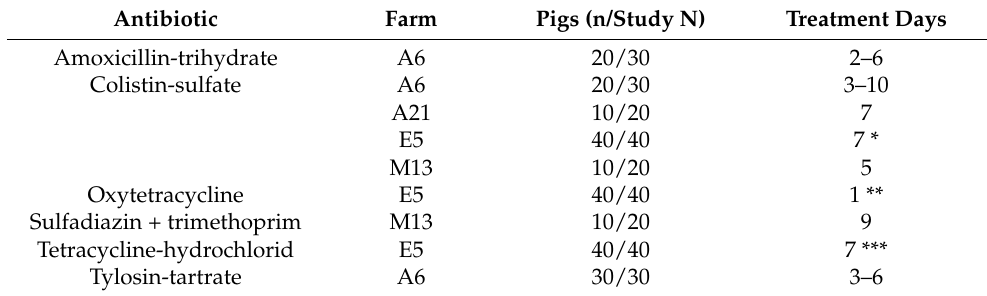
Table 7. Antibiotics applied in study animals.